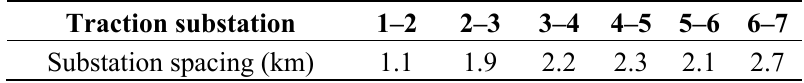
Table 1. TSS spacing distances.